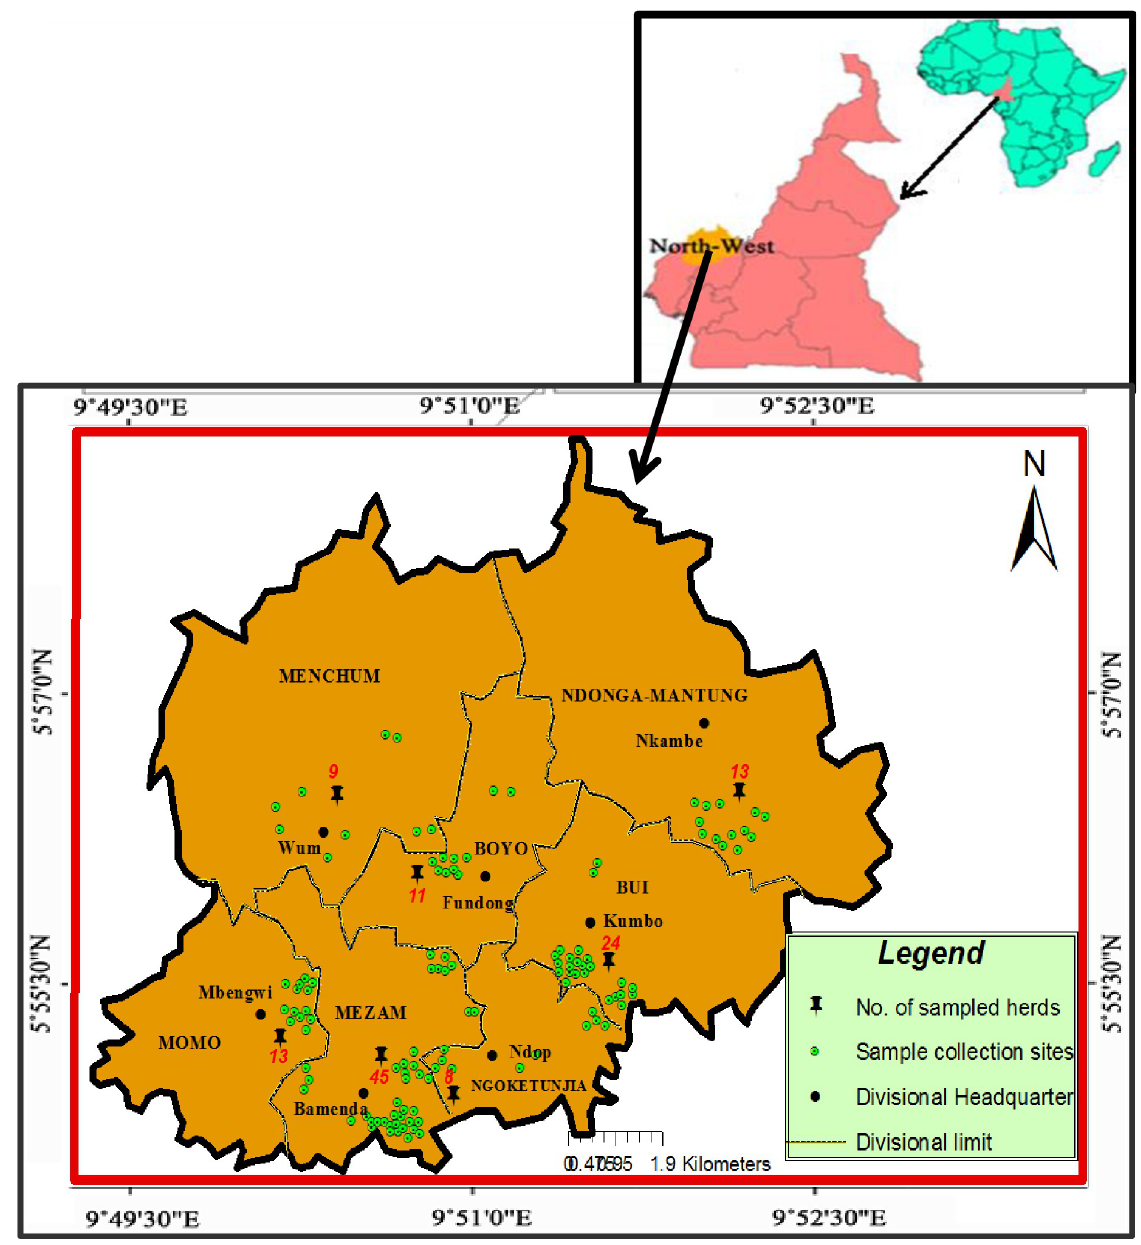
Fig 1. Map of the study area showing sample collection